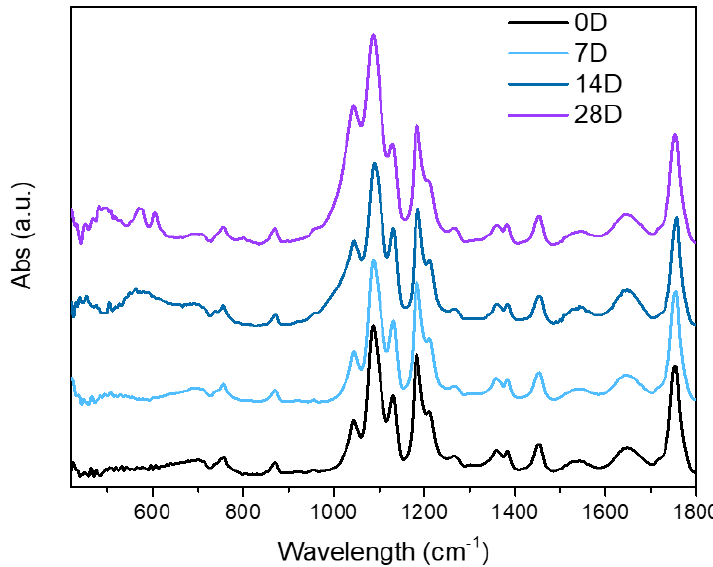
Figure 7. ATR-FTIR analysis of the coated polymeric scaffold at different time of soaking in SBF (0 (0D), 3 (3D), 14 (14D) and 28 days (28D)).